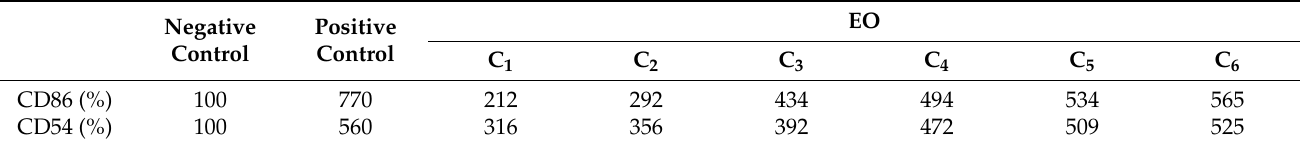
Table 3. CD86 (%) and CD54 (%) values obtained for the in vitro assessment of skin sensitization assay.